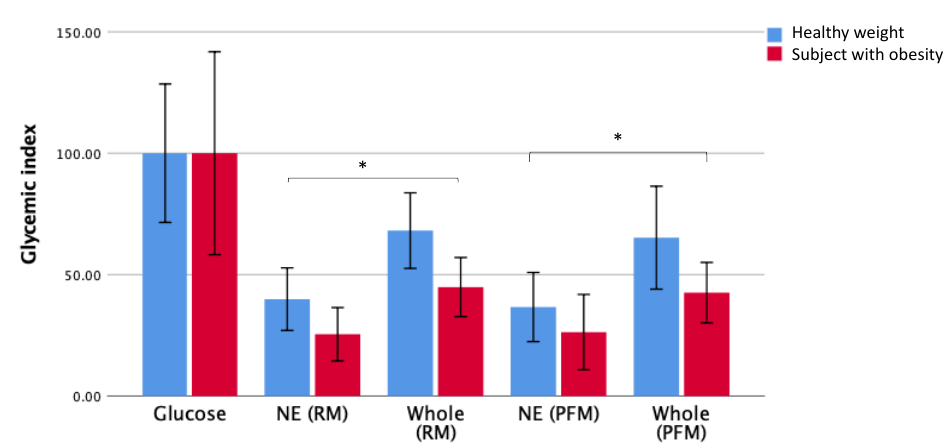
Figure 4. Comparison of GI for each test meal for groups with a healthy weight and obesity. NE = nutrient extracted; RM = raspberry/mango: PFM = passionfruit/mango * indicates a significant difference between NE and whole fruits in both individuals with healthy weight and obesity, p < 0.05.